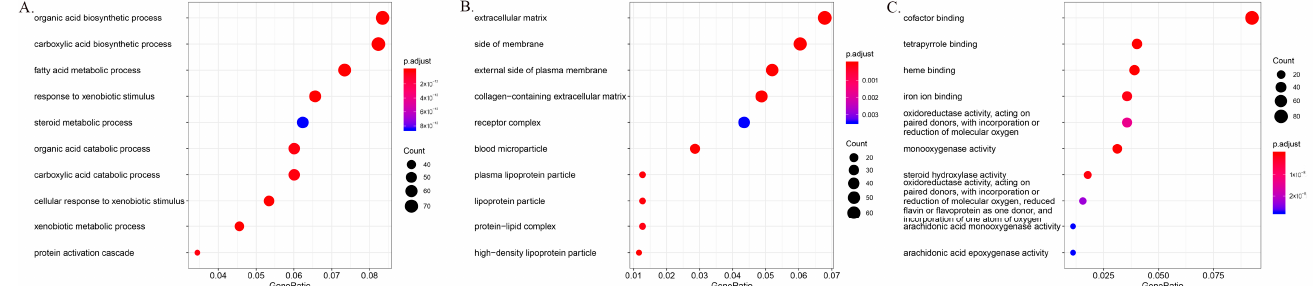
Figure 3. Gene Ontology enrichment analysis of upregulated mRNA between hepatocellular carci- noma and para-carcinoma tissues: ( A ) biological process, ( B ) cell component, ( C ) molecular func- tion.